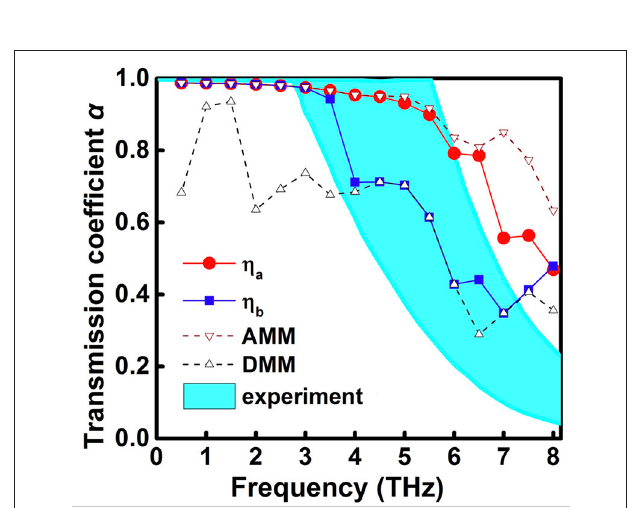
FIGURE 4 | Comparison of the transmission coefficient α of our proposed MMM (specified symbols) with those obtained from the AMM (downward open triangles), DMM (upward open triangles), and experimental data (light blue region) (Hua et al.,